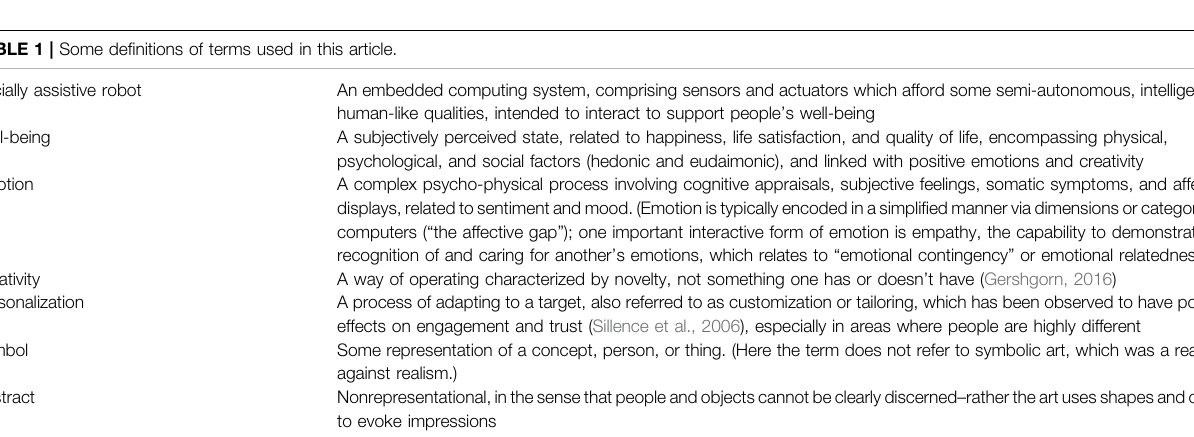
TABLE 1 | Some de fi nitions of terms used in this article. Socially assistive